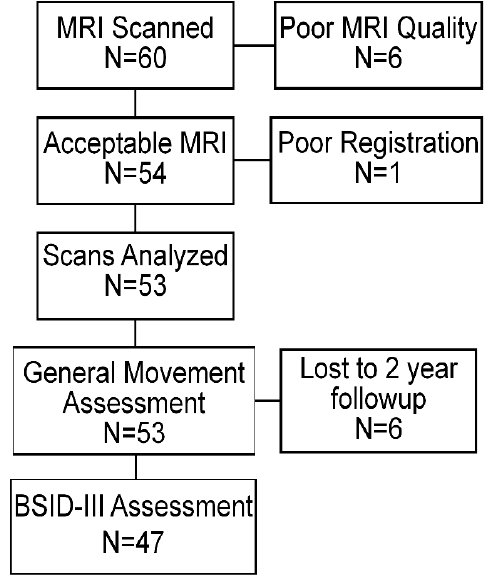
Figure 1. Subject flow through the study. Table 3 . Statistical comparison of clinical characteristics likely to affect neurologic functioning in infants who had functional MRI scans and General Movement assessments with those who had General Movement assessments only.